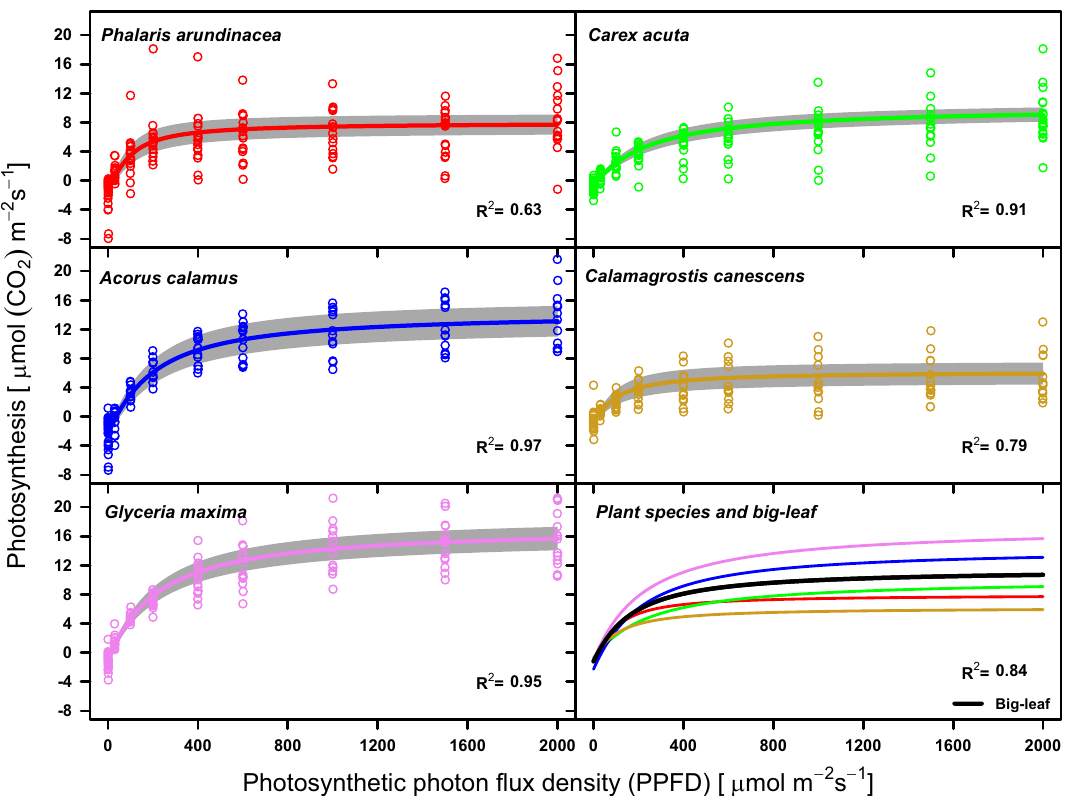
Figure 5. Photosynthesis–irradiance (PPFD) relationship (P N /I) of the five plant species and weighted P N /I relationship for a theoretical “ecosystem big-leaf” (black line) modelled by non-rectangular hyperbolas. Grey areas represents standard errors of average P N /I